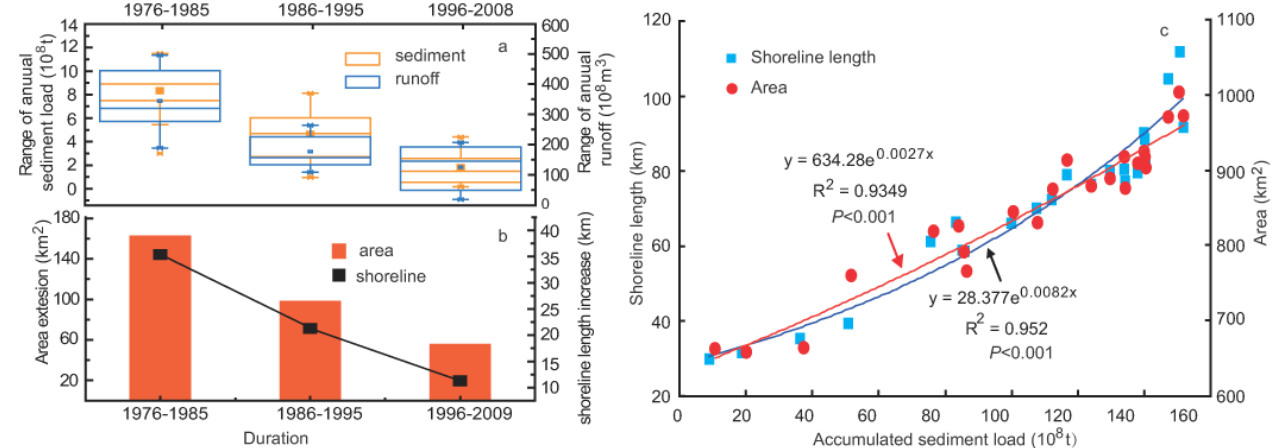
Fig. 6. The sediment load, runoff (a) and area extension (b) in different delta evolution stages, and relationships between the accumulated sediment and the shoreline length and area of Yellow River Delta (c)